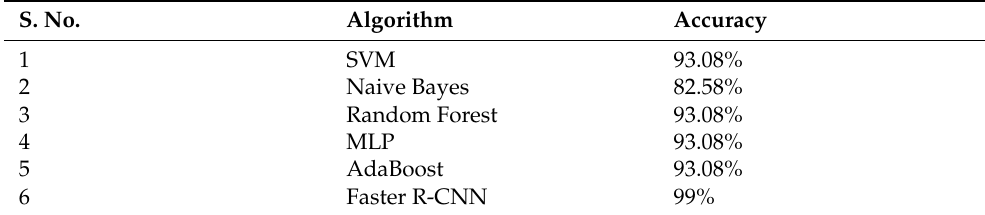
Table 3. Comparative analysis of the proposed model.